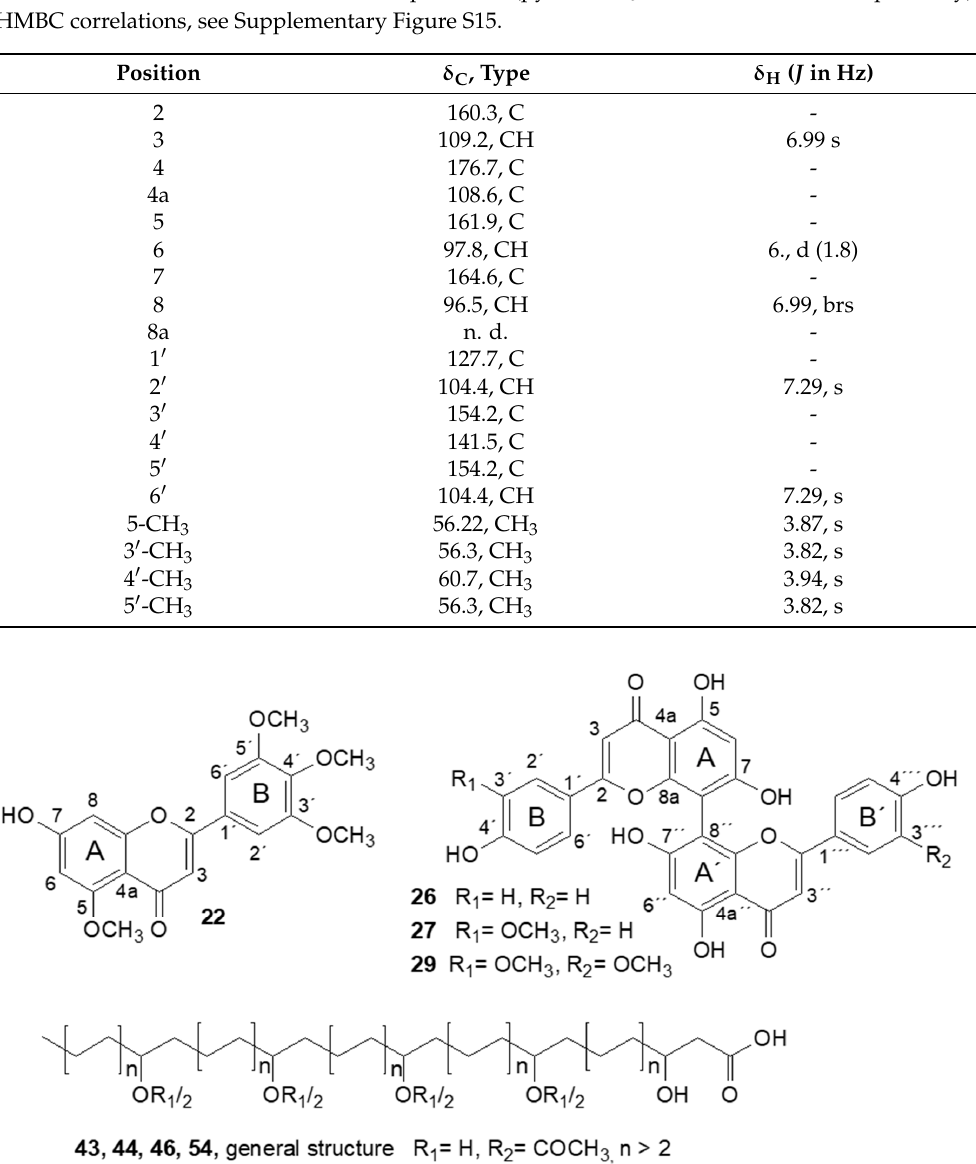
Figure 3. Structures of isolated compounds 22 , 26 , 27 and 29 and general structure of isolated com- pounds 43 , 44 , 46 and 54 . HMBC correlations; see Supplementary Figure S15. The 1 H spectrum of 27 displayed a higher number of resonances than that of 26 . Cou- pling patterns indicated a different substitution in one of the B-rings, while the other parts of the molecule displayed a pseudosymmetric arrangement. Based on HMBC correlations, the position of the additional OCH 3 group was identified as C-3 ′ , allowing us to assign compound 27 to 3 ′ -methoxycupressuflavone (Figure 3). In the case of 29 , the low number of proton resonances supported the symmetric substitution pattern indicated by the MS/MS data. HMBC correlations enabled the assignment of two methoxy groups to posi- tions 3 ″ and 3 ‴ in the two apigenin subunits, allowing us to identify the compound as 3 ′ ,3 ‴ - dimethoxycupressuflavone (Figure 3). Compounds 27 and 29 have only been described once before by Jang et al. [43] reported the isolation of these compounds from Zabelia tyai- hyoni (Nakai) Hisauti & H. Hara (Caprifoliaceae). Consequently, this is the first report of the isolation of these compounds from a Lonicera species. Compounds 43 , 44 , 46 and 54 were obtained as amorphous white solids. HR-MS data indicated a molecular formula of C 36 H 68 O 9 for 43 , 44 and 46 , and of C 38 H 72 O 9 for 54 , and three double bond equivalents in all four constituents. In the 1 H NMR spectrum of com- pound 46 , a terminal CH 3 group ( δ H = 0.89 ppm) could be assigned. Broad signal groups between 1.30 and 1.60 ppm indicated the presence of a saturated alkyl chain with widely overlapping proton signals (Supplementary Figure S16). The HSQC spectrum (Supple- mentary Figure S17) determined the presence of five hydroxymethine groups. Two of these were found to bear acetyl moieties, the methyl group of which appeared as sharp singlet at a shift of 2.02 ppm in the proton spectrum. HMBC correlations indicated the presence of three carbonyl functional groups; two of these were assigned to the acetyl moieties ( δ c = 172.9 ppm) and the third to the carboxyl moiety at position 1 ( δ c = 176.9 ppm) (Supplementary Figure S18 and Table 4). Starting from the carboxyl group at posi- tion 1, a CH 2 group was assigned to position C-2 ( δ c = 43.7 ppm), and a CHOH group to position C-3 ( δ c = 69.6 ppm); via their HMBC correlations, the CH 2 groups at position C-4 ( δ c = 38.4 ppm) and C-5 ( δ c = 22.4 ppm) could be assigned as well. The terminal CH 3 group ( δ c = 14.5 ppm) displayed typical HMBC correlations for alkyl chains with a length of at least five carbon atoms. The remaining two CHOH groups showed only two HMBC cor- relations ( δ c = 38.1 ppm and 22.7 ppm). This indicates that the C atoms that couple to these two groups via two or three bonds display the same or a very similar chemical environ- ment. For the two CHOCOCH 3 groups, three HMBC correlations ( δ c = 35.3 ppm, 26.4 ppm and 22.2 ppm) were detectable, indicating a slightly different chemical environment for the two groups (Supplementary Figure S19). The nonoverlapping HMBC correlations for